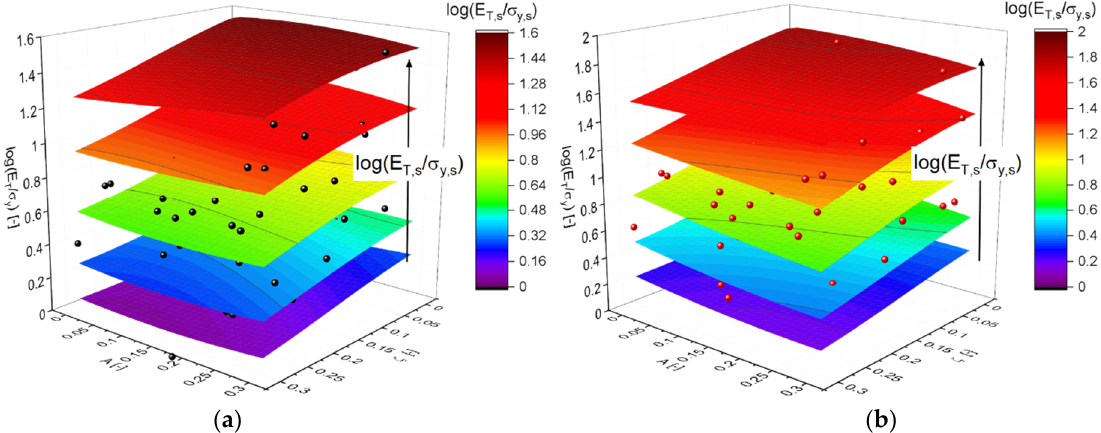
Figure 10. Approximation of the simulation results for the macroscopic plastic properties (spheres) by MLP regression (shown as contour plot) as functions of randomization A and cut fraction ζ : ( a ) G 21 : ϕ = 0.12, ( b ) G 33 : ϕ = 0.35.